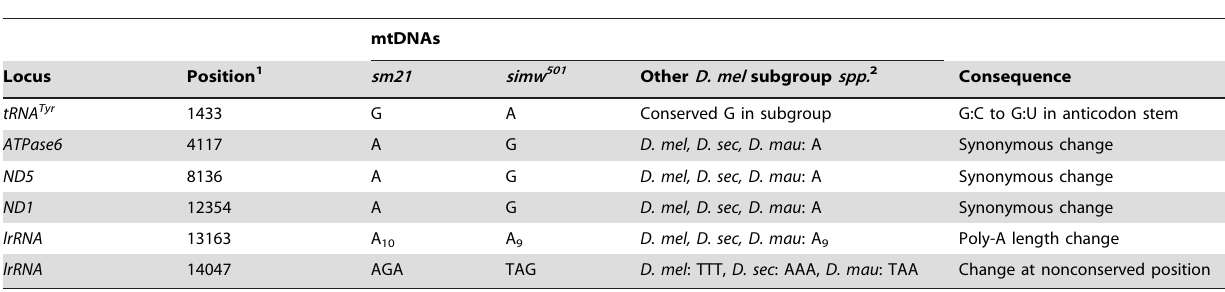
Table 1. Divergent sites between the D. simulans sm21 and simw 501